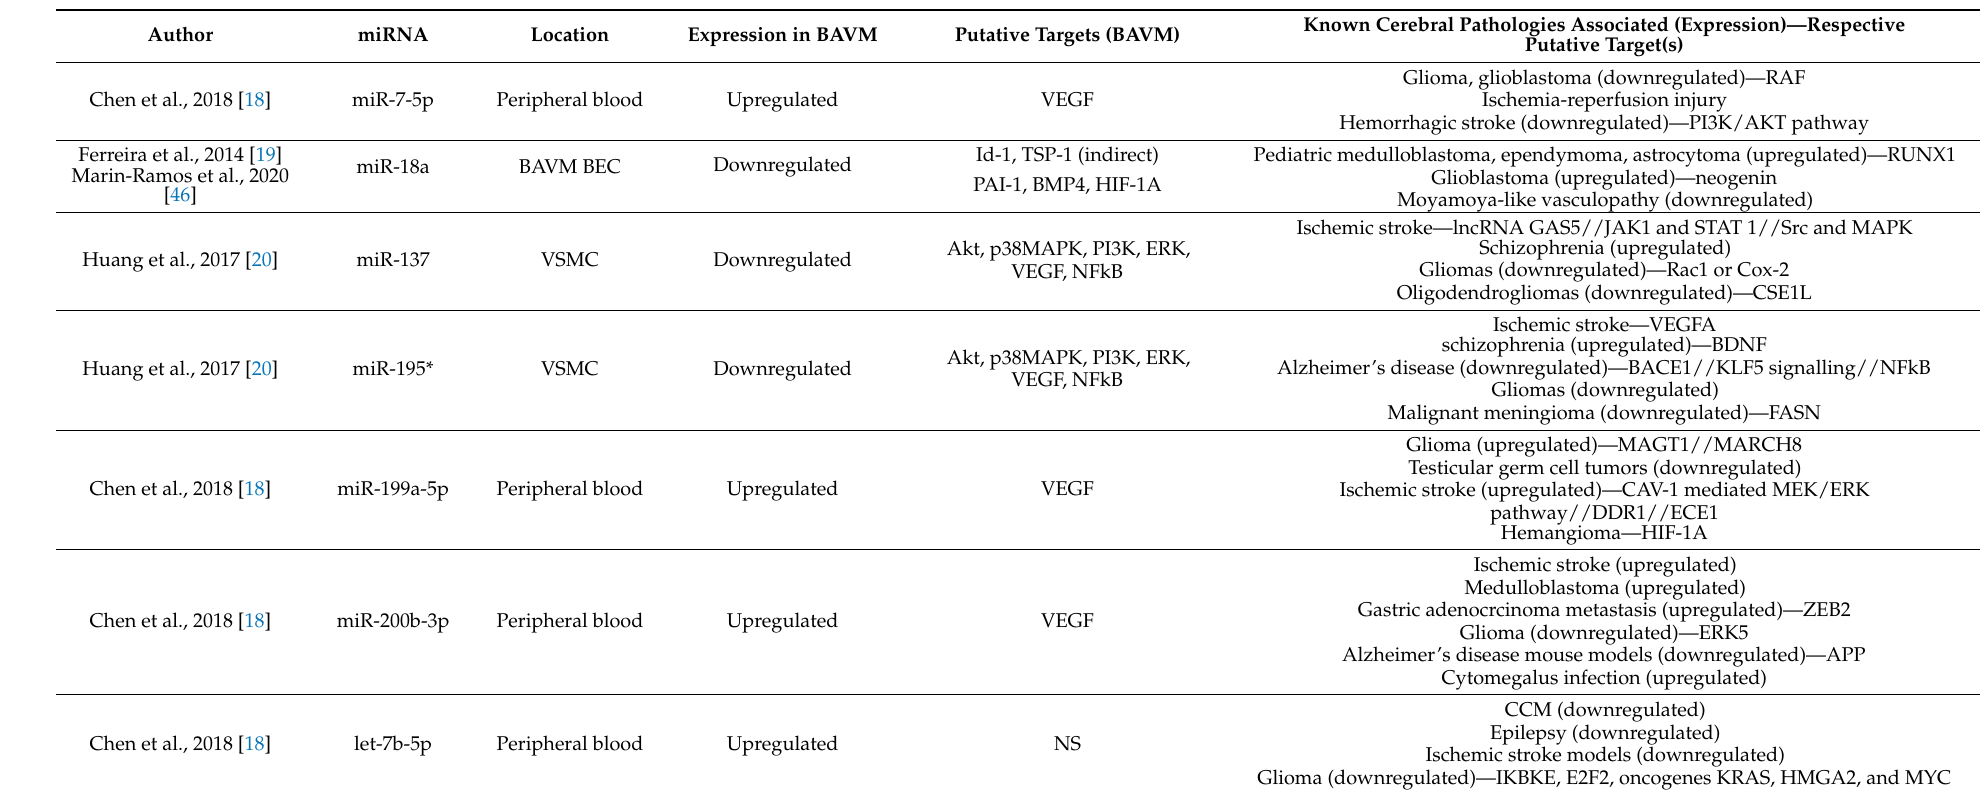
Table 1. Location, Expression and Putative Targets of Identified microRNAs in Brain Arteriovenous